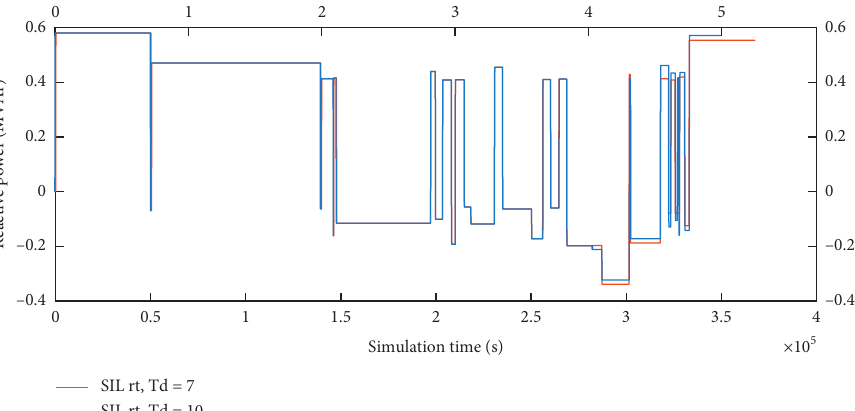
Figure 14: Results of the real-time SIL simulations. Reactive power flow of the WTconverter when T was set up to the TSO limits of ± 50 kVAr, except QD 1 � Q i +200